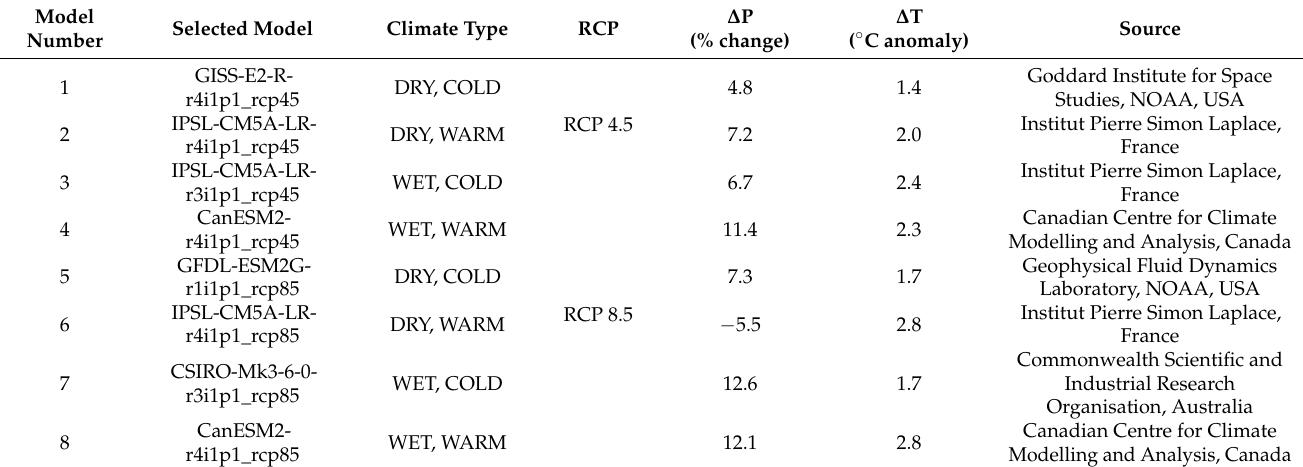
Table 3. Selected CC models, climatic conditions, and average projected precipitation and temperature change over the whole Brahmaputra basin.